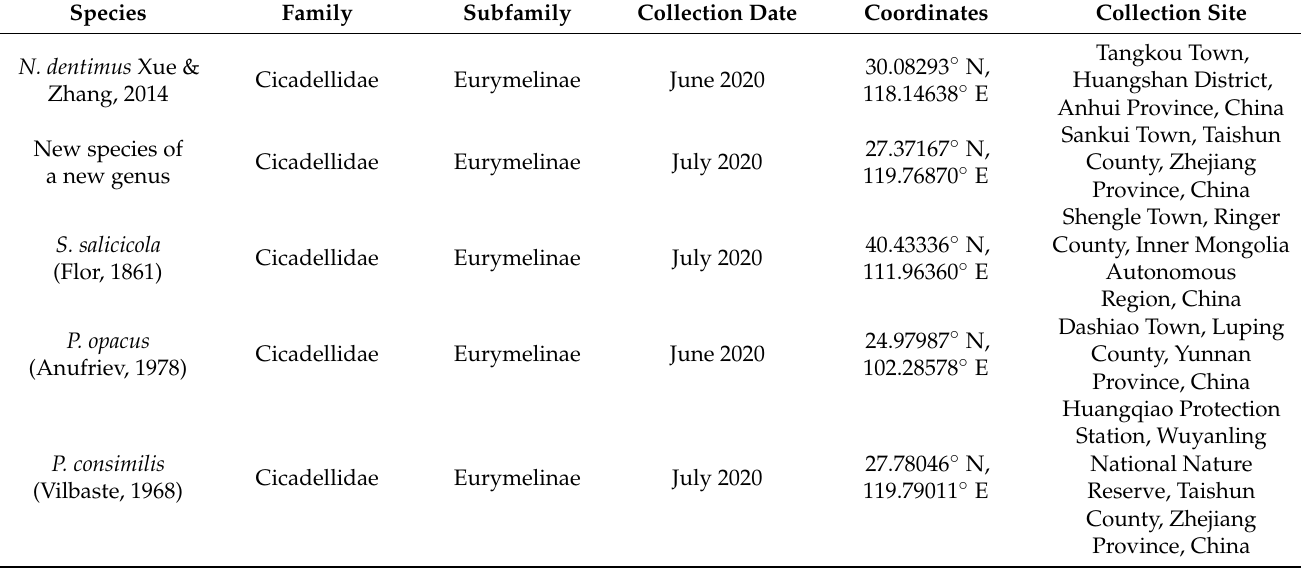
Table 1. List of the collection information for five species in the tribe Idiocerini.